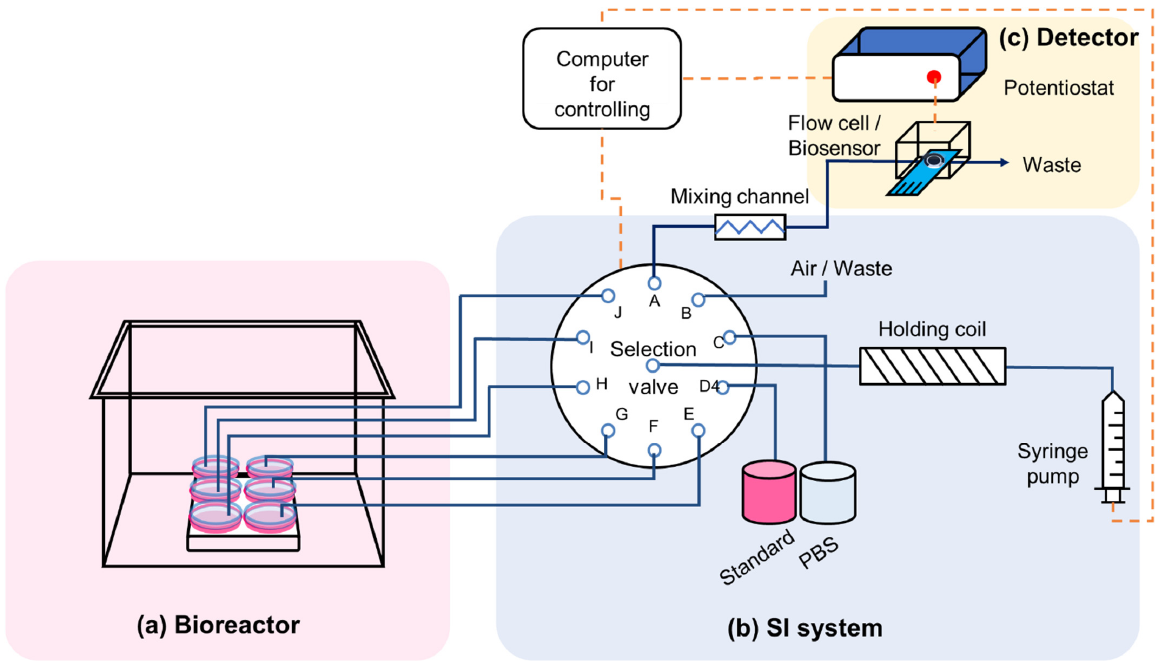
Figure 5. A specially designed new system for in ‐ line glucose monitoring in cell culture application is composed of three parts: ( a ) bioreactor, ( b ) SI system, and ( c ) detector.